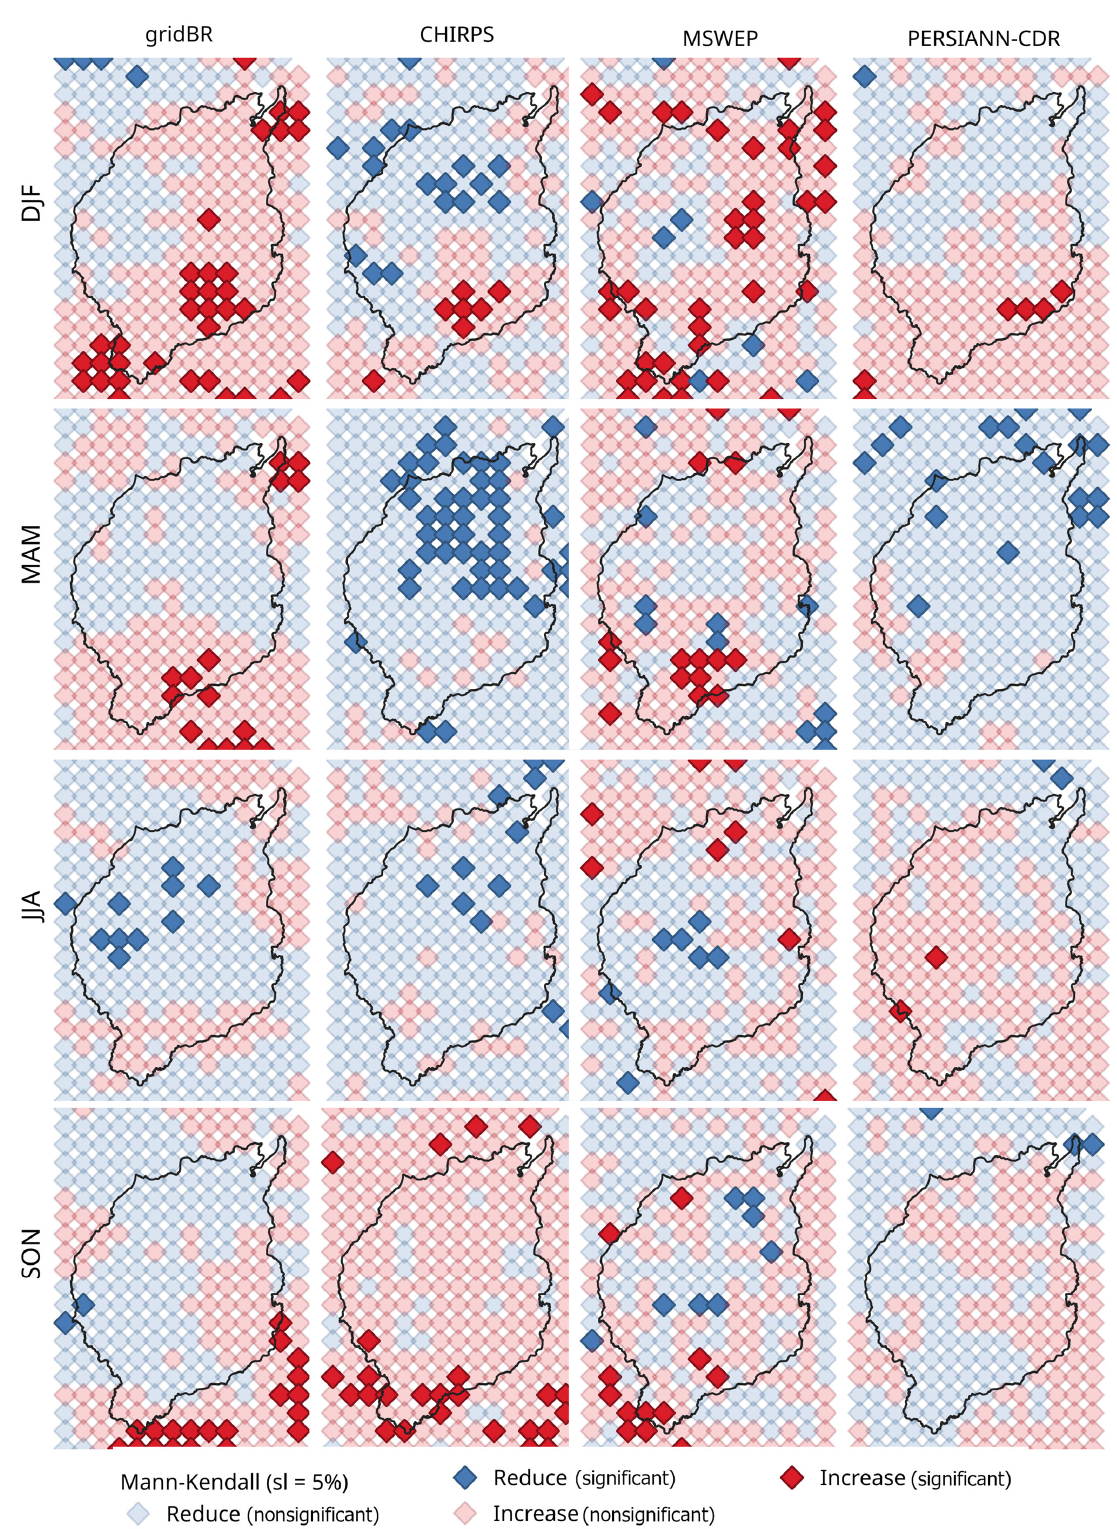
Figure 15. Mann–Kendall decreasing and increasing trends (5% level of statistical significance) as Figure 1. Day of daily rainfall in the MDB (gridBR × RES) from 1983 to 2013.